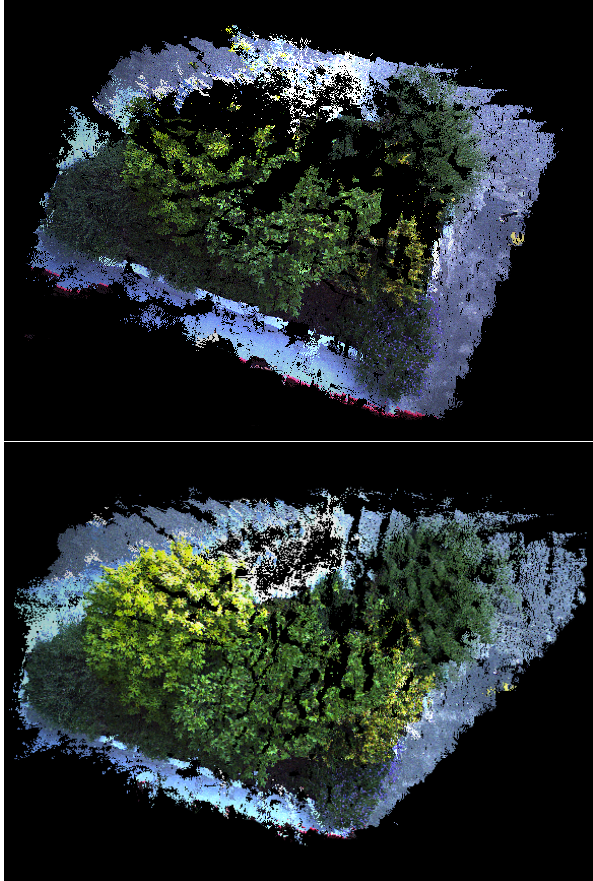
Figure 2: Top: 3D reconstruction obtained using unsynchronized images (about 1 second delay), Bottom: 3D reconstruction ob- tained using synchronized images (to the hundredth of a